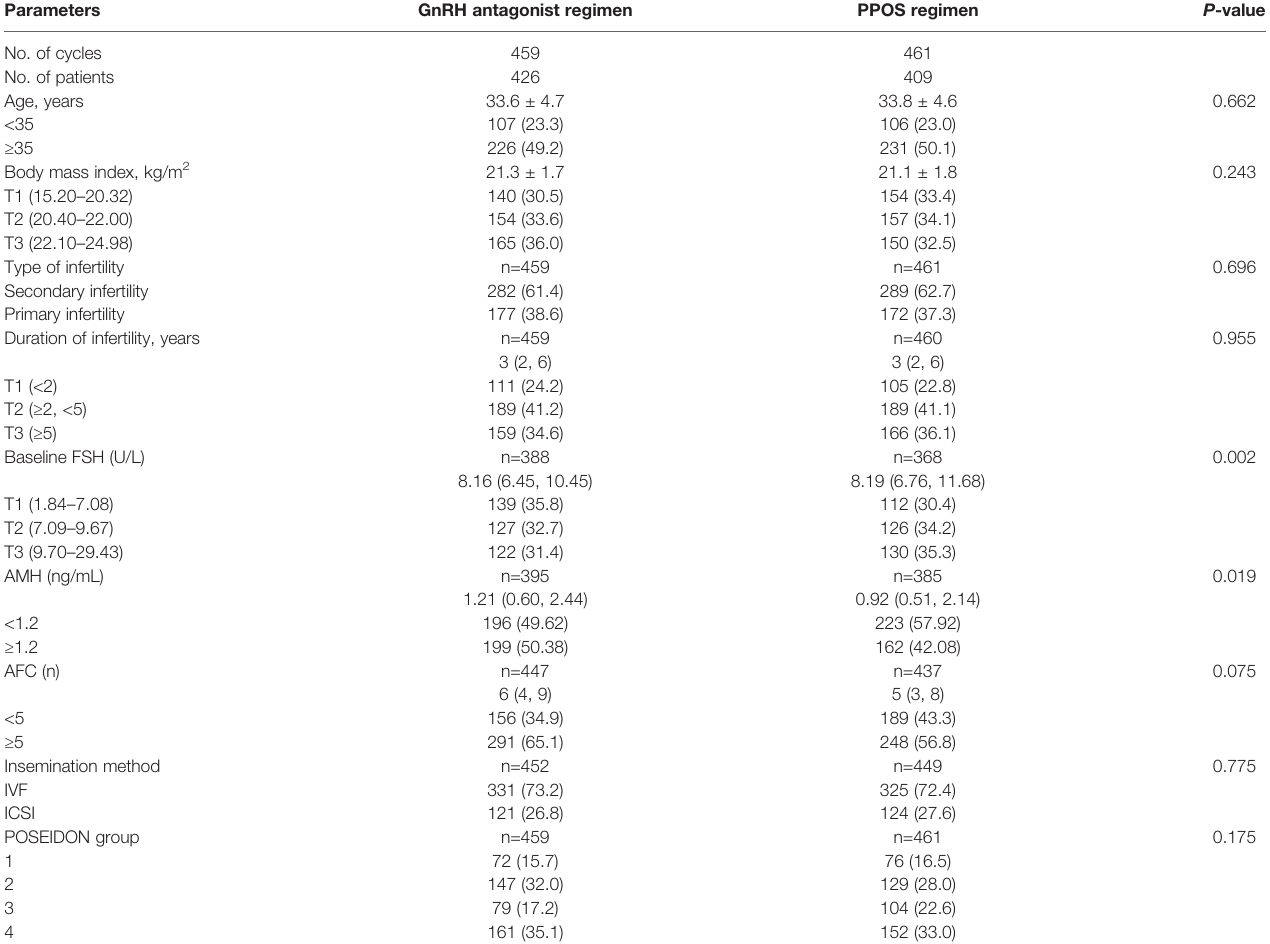
TABLE 1 | Characteristics of the two COS regimen